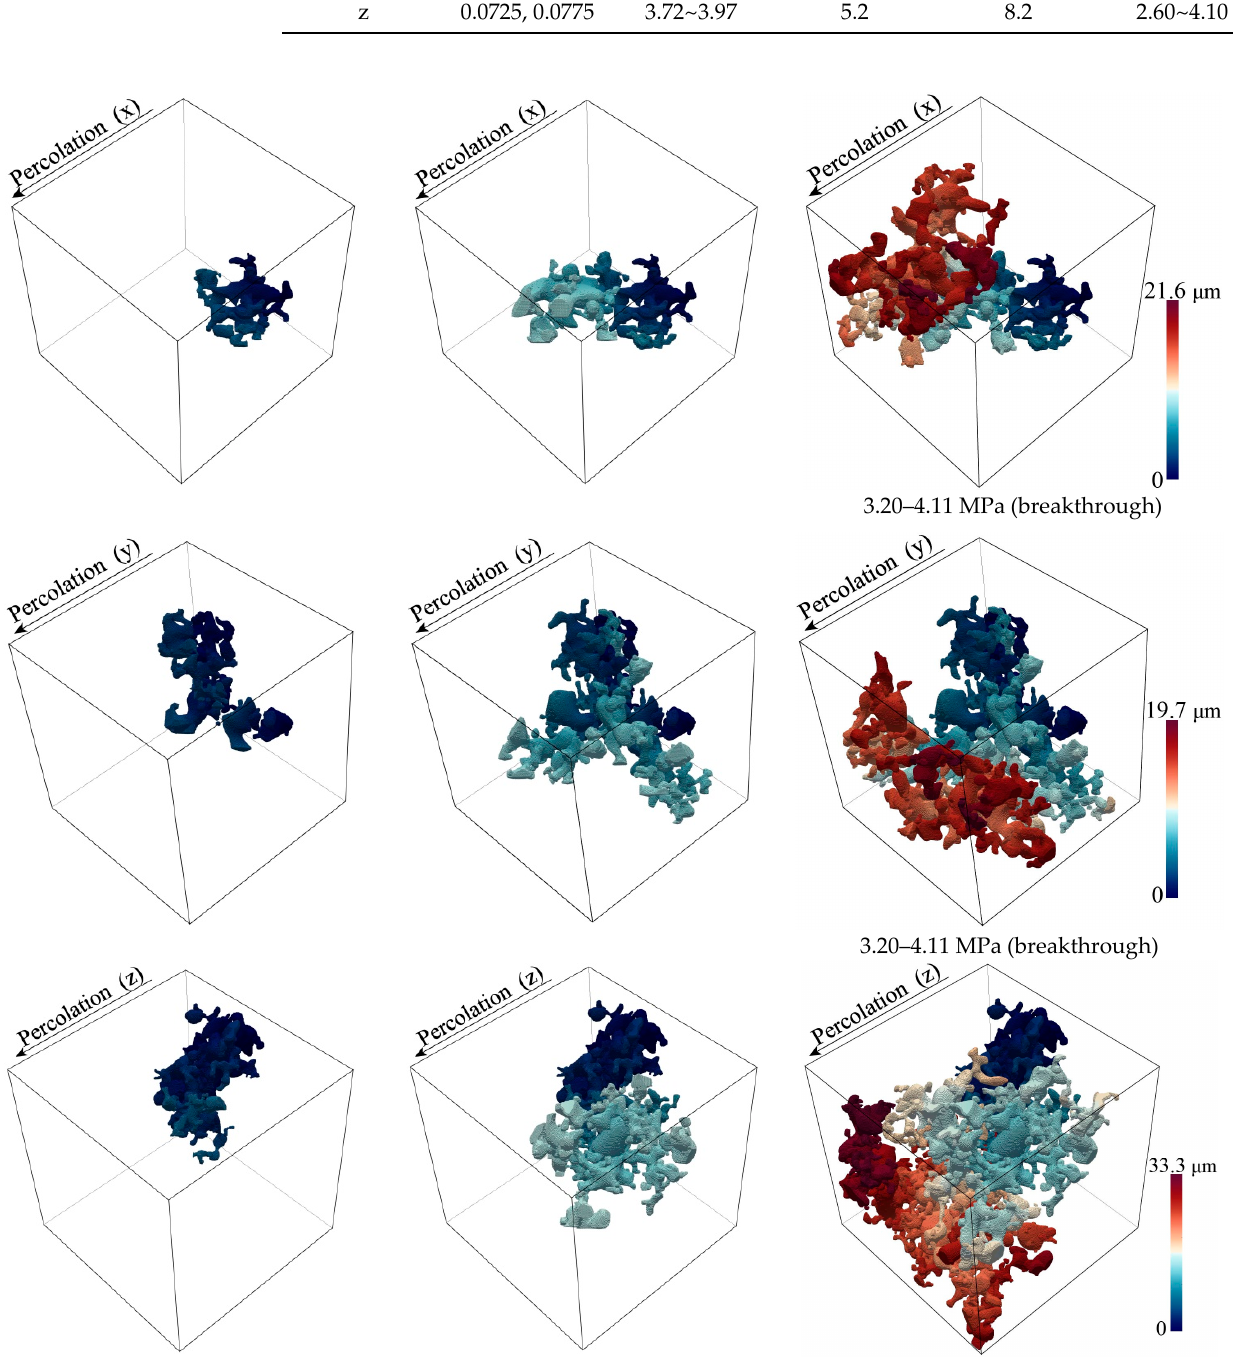
Figure 15. Gas migration in the Boom clay model.